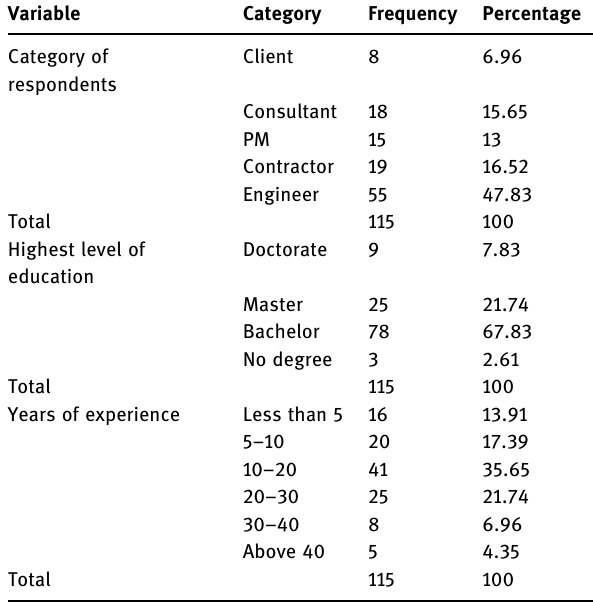
Table 1: Respondent demographic